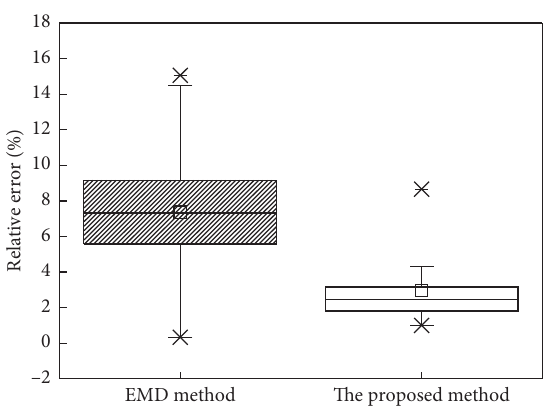
Figure 12: Relative positioning error